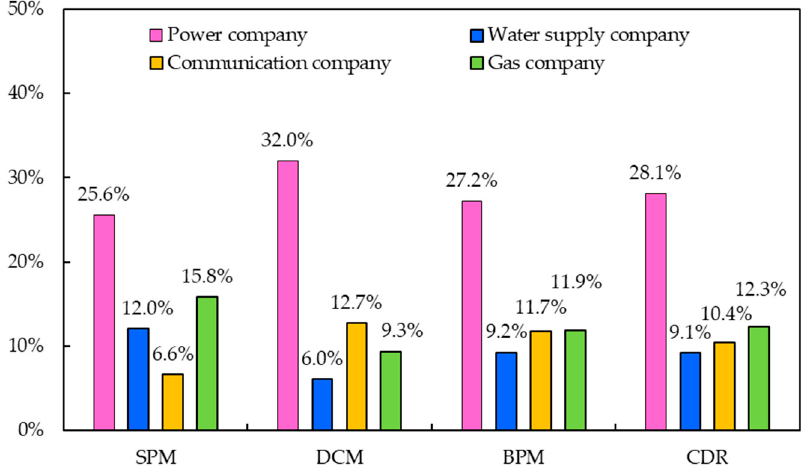
Figure 4. Cost allocation proportion of pipeline companies.